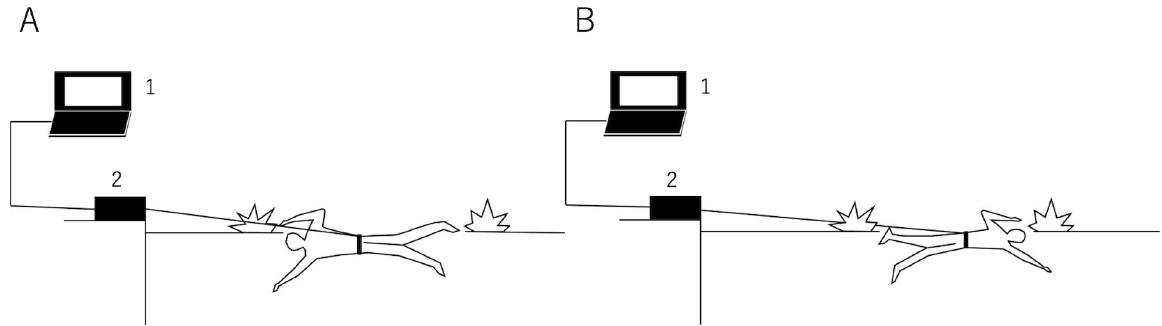
Fig. 1. Apparatus used for the measurements. (A) Assisted swimming (A-swim) in which swimmers were towed in the propulsion direction using a towing device. (B) Free swimming (N-swim) in which the swimmers were not towed (zero load) by a towing device. 1 = Personal Computer, 2 = towing device. Table 1. Performance variables at Submax and Maximum effort (data are means ± SD). N-swim Variables Effort